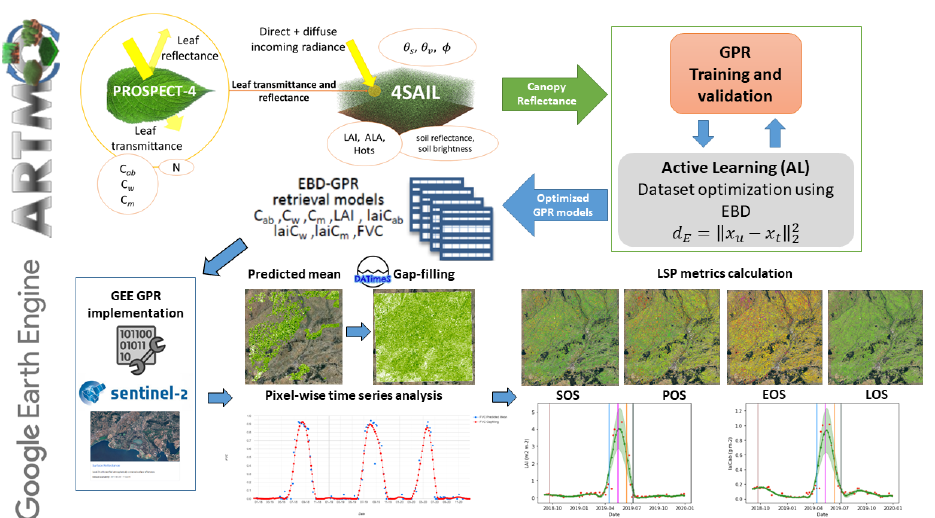
Figure 1. Flowchart of the pursued workflow. Upper: development of hybrid retrieval models in ARTMO by the coupling of leaf-canopy RTMs for training dataset generation, followed by AL optimization and GPR model building. Lower: integration of AL-optimized GPR Euclidean distance- based diversity models (EBD-GPR) on GEE for the retrieval of multiple crop traits from S2 BOA data, subsequent time series gap-filling, and phenology metric